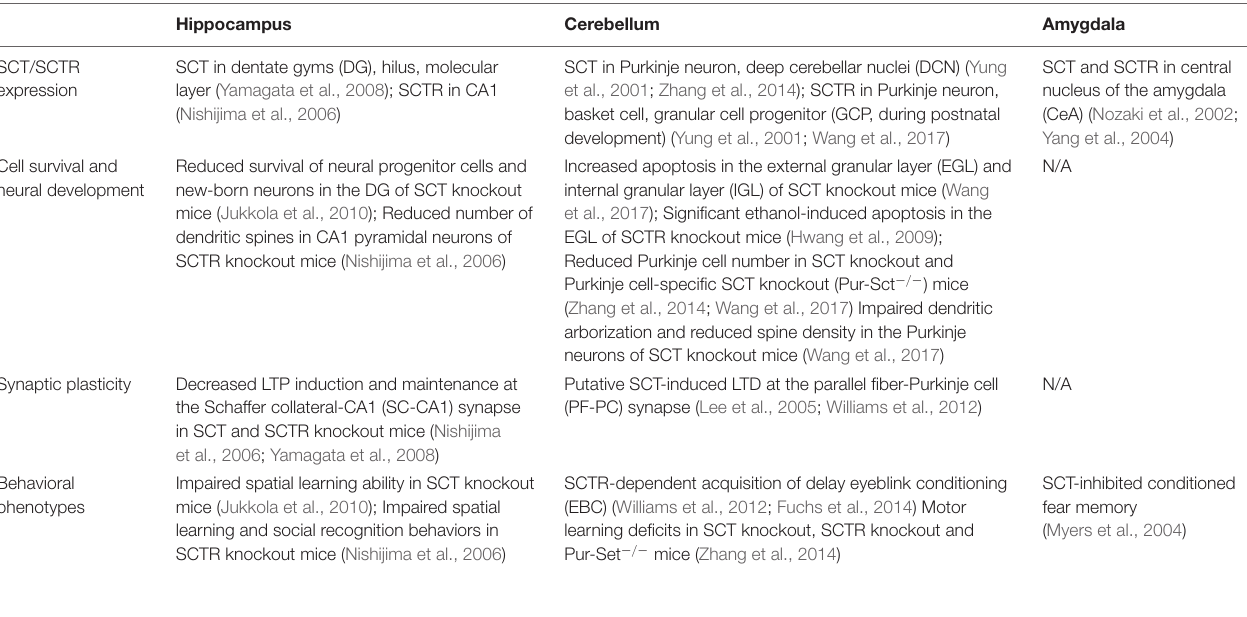
TABLE 1 | Cellular distribution of SCT/SCTR and their effects on cell survival and synaptic plasticity in specific brain regions: implications for learning and memory. Hippocampus SCT/SCTR